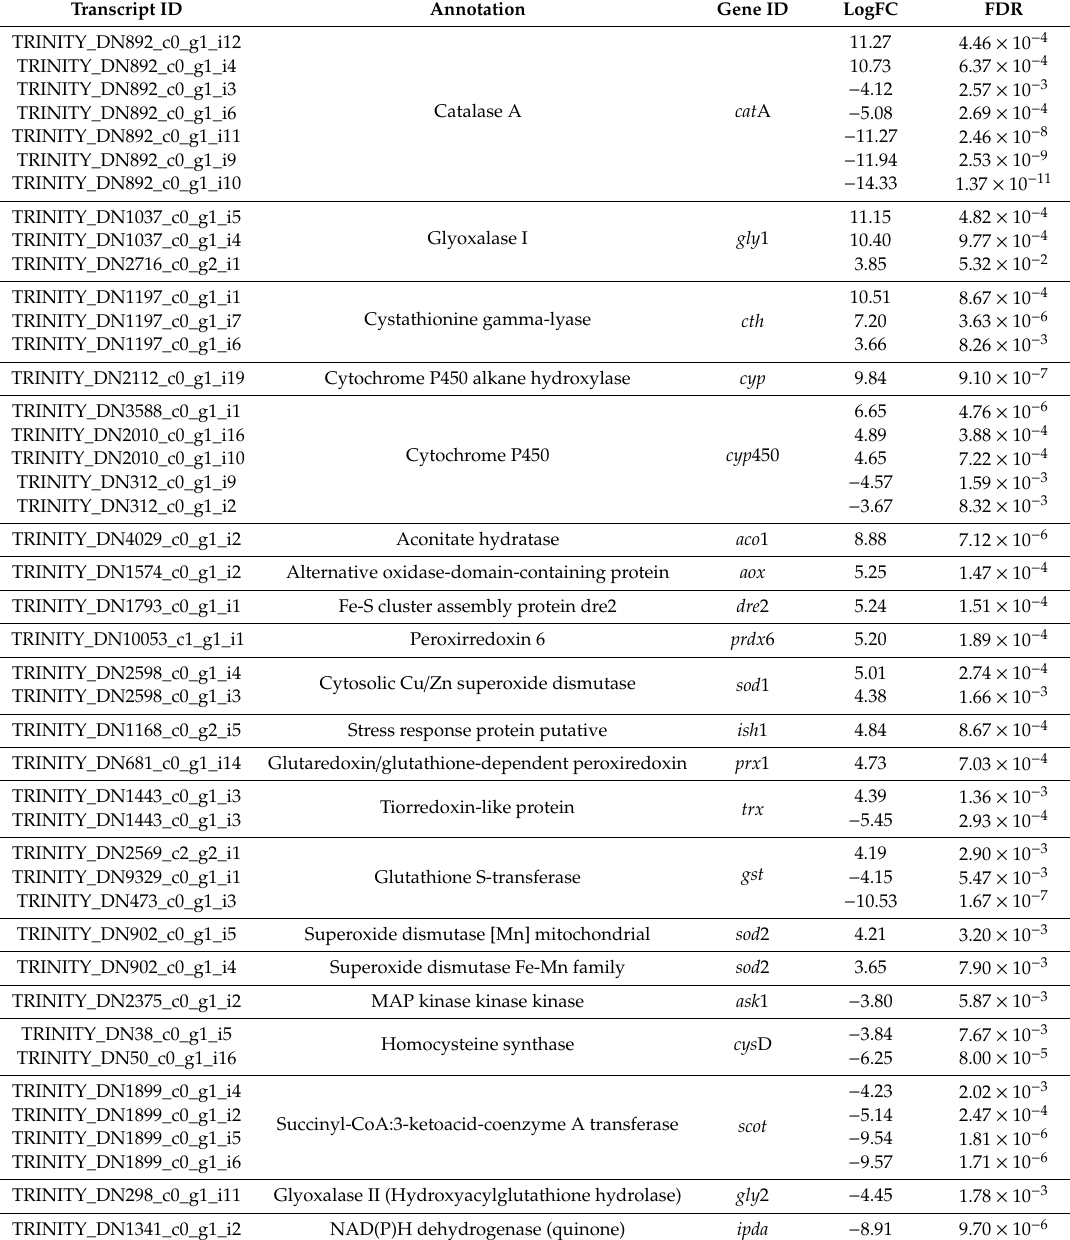
Table 1. Transcriptomic expression of Aspergillus sydowii EXF-12860’s genes related to oxidative stress responses induced by hypersaline